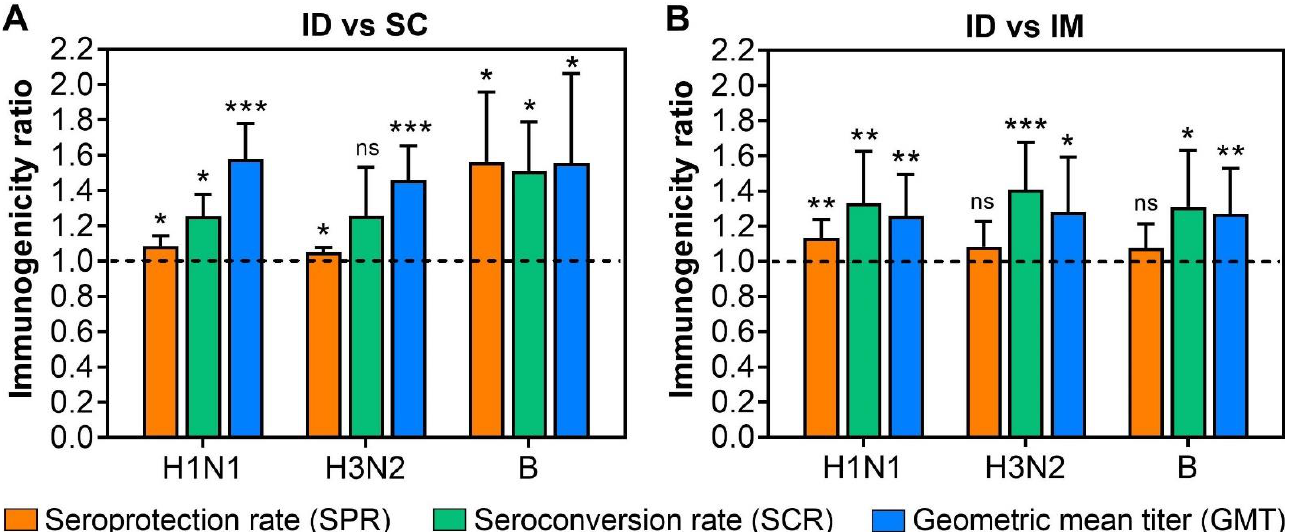
Figure 1. Comparison of the immunogenicity of standard-dose influenza vaccines delivered by in- tradermal (ID) and intramuscular (IM), or subcutaneous (SC) routes in the elderly. The ratios of seroprotection rate (SPR), seroconversion rate (SCR), and geometric mean titer (GMT) were calcu- lated by dividing the mean SPR, SCR, and GMT of ID vaccination by those induced by IM or SC vaccinations. A ratio of >1 (dash line) implies greater immune responses induced by ID vaccination than IM or SC vaccinations. ( A ) At the same antigen dosage (15 µg of HA for each antigen), ID vaccination induced greater SPR, SCR, and GMT for each viral vaccine strain than SC vaccination. ( B ) Similarly, the SPR, SCR, and GMT elicited by ID vaccination were greater than those induced by IM vaccination. One sample t-test was used to examine the significant difference in the immuno- genicity ratios against the hypothesized ratio of 1. “ns” = non - significant, “*” = p < 0.05, “**” = p < 0.01, “***” = p < 0.001.